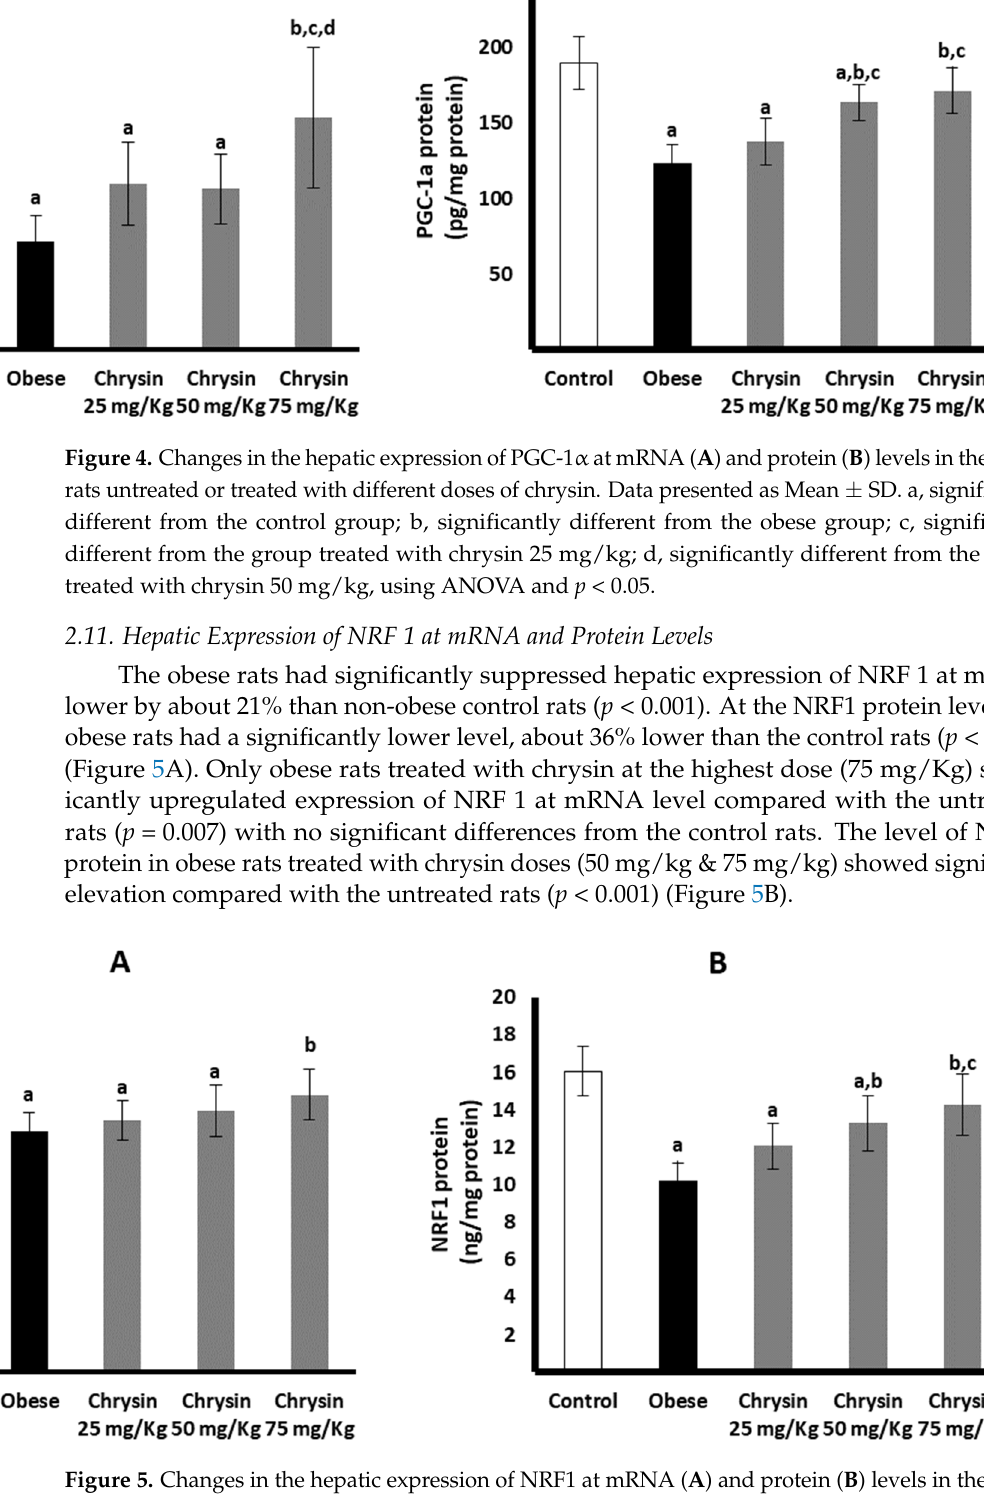
Figure 5. Changes in the hepatic expression of NRF1 at mRNA ( A ) and protein ( B ) levels in the obese rats untreated or treated with different doses of Chrysin. Data presented as Mean ± SD. a, significantly different from the control group; b, significantly different from the obese group; c, significantly different from the group treated with Chrysin 25 mg/kg, using ANOVA and p < 0.05.